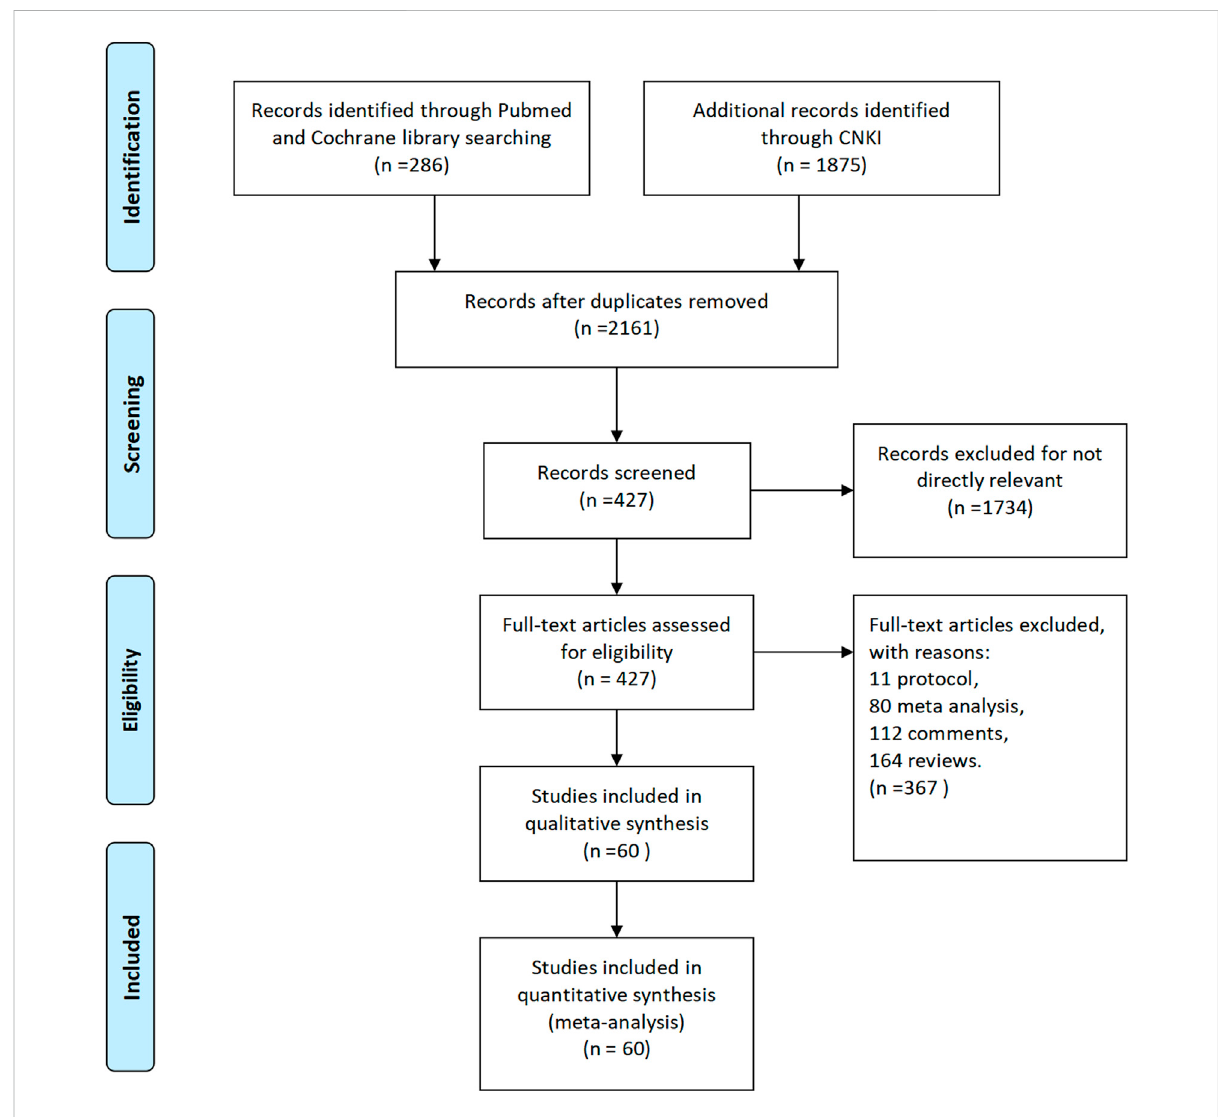
Flow diagram for study identi fi